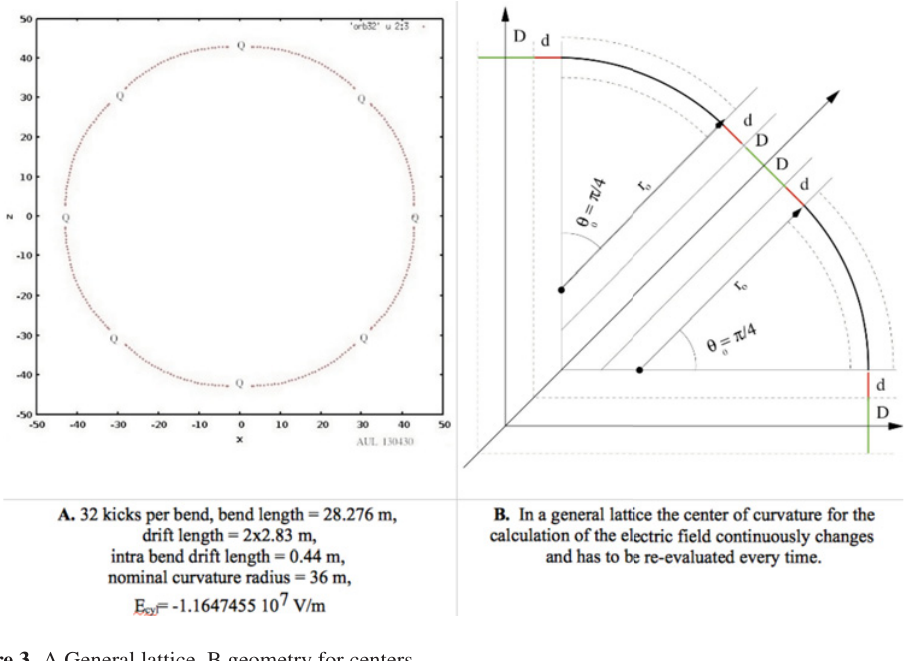
Figure 3. A.General lattice, B.geometry for